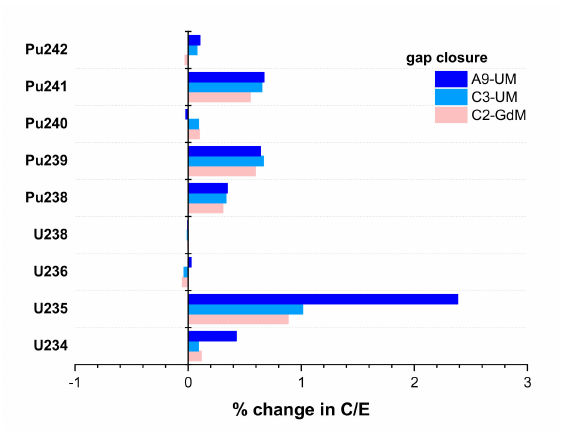
Figure 7. Change in U and Pu C/E isotope concentration ratios due to gap closure for samples from assembly 2F1ZN3.